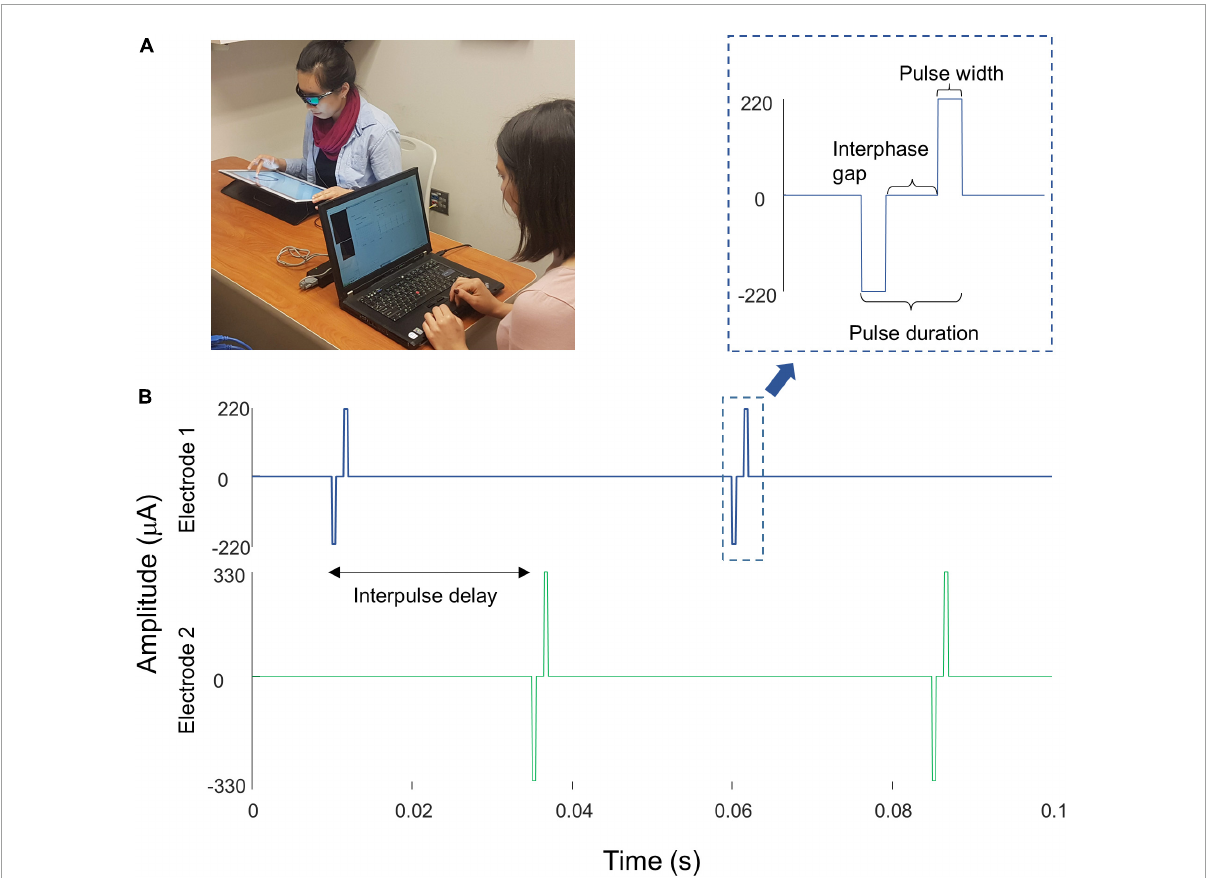
FIGURE1 (A) Experimental setup. (B) Example pulse trains for an individual trial (not to scale) of the two-point discrimination paradigm. In all experiments we used square-wave, biphasic, cathodic-first pulse trains with a fixed pulse train